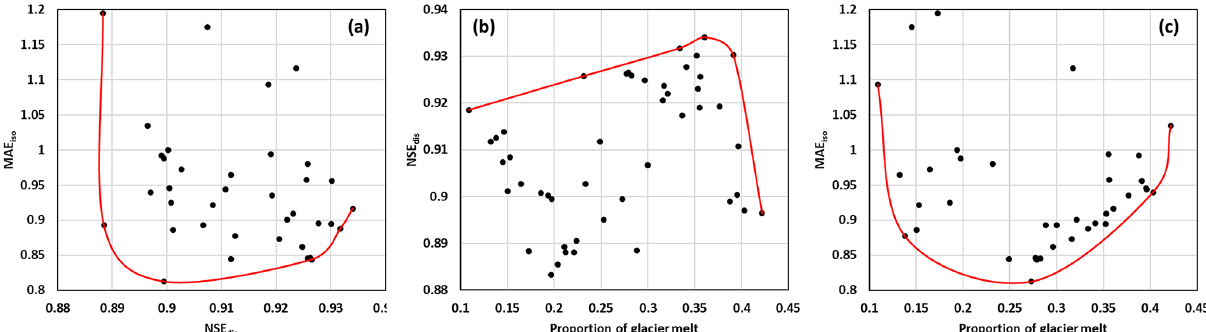
Figure 12. The relationships between the (a) MAE iso and NSE dis , (b) NSE dis and glacier melt contribution and (c) MAE iso and glacier melt